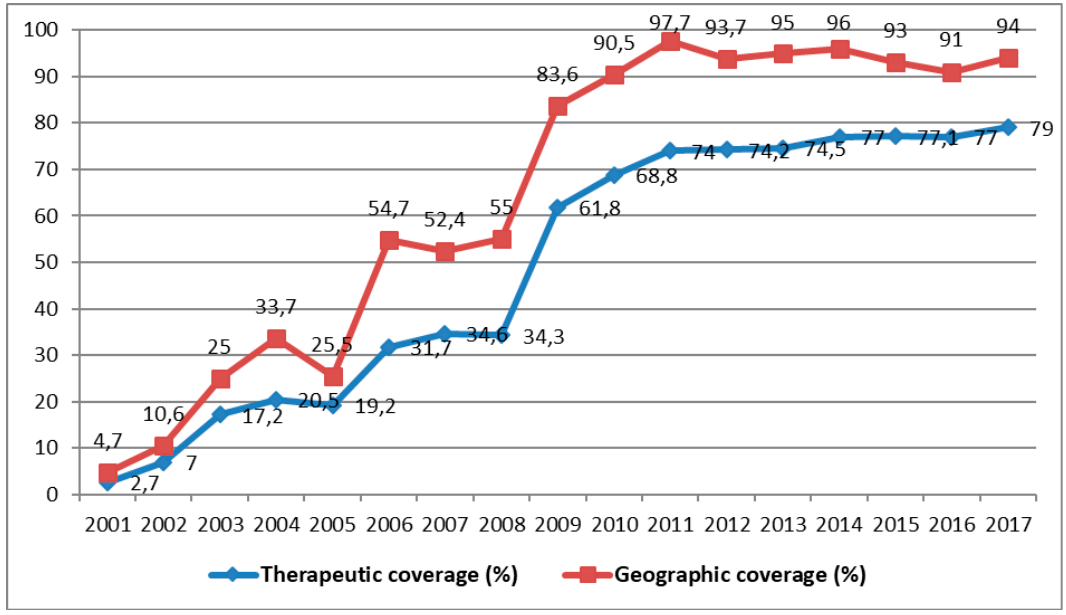
Figure 5. Evolution of therapeutic and geographic coverage of treatment for onchocerciasis from 2001 to 2017 (Source: MS/SG/PNMTN-CTP 2018).